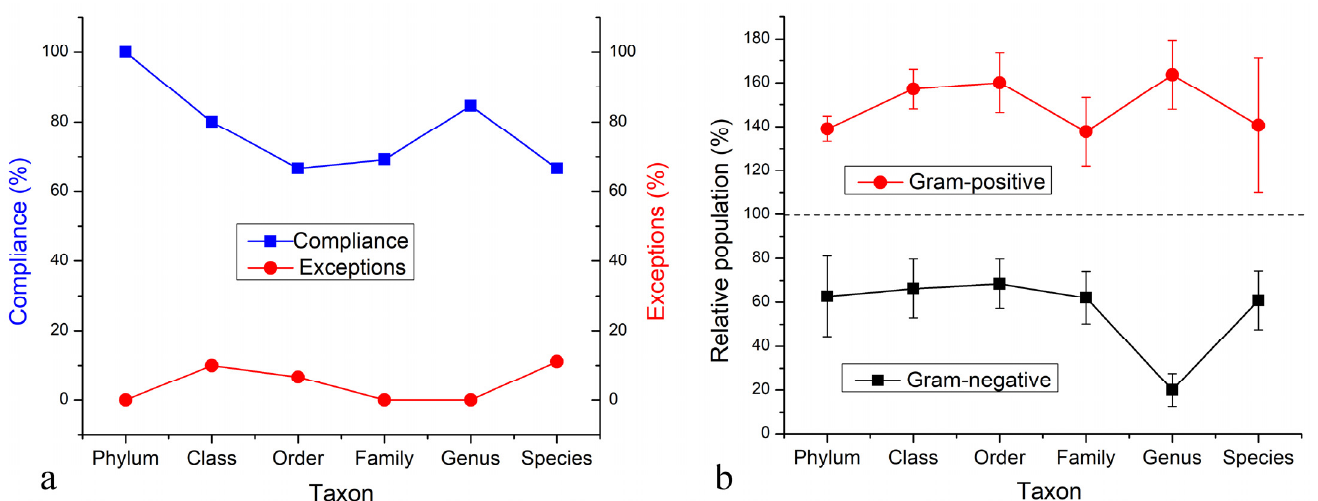
Figure 7. Percentage of taxa conforming to the trend of HAp decreasing the relative presence of Gram-negative populations and increasing the relative presence of Gram-positive populations (blue line), and the percentage of exceptions to this trend (red line) ( a ). The two values expressed in percentages must have the percentage of calls that were equal for the untreated and treated sample groups added to them to reach 100%. Average change in the relative population of a Gram-negative and a Gram-positive taxon for each hierarchical level of the classical nomenclature relative to the untreated control ( b ). Data points in ( b ) represent averages, while error bars represent the standard errors of the mean. Dashed line in ( b ) represents the 100% concentration of the control. All phyla, classes, orders, families, genera and species whose concentrations in the microbiome were higher than or equal to 1, 0.5, 2, 3, 1, and 0.1%, respectively, in either the treated or untreated soils are included among the data points.